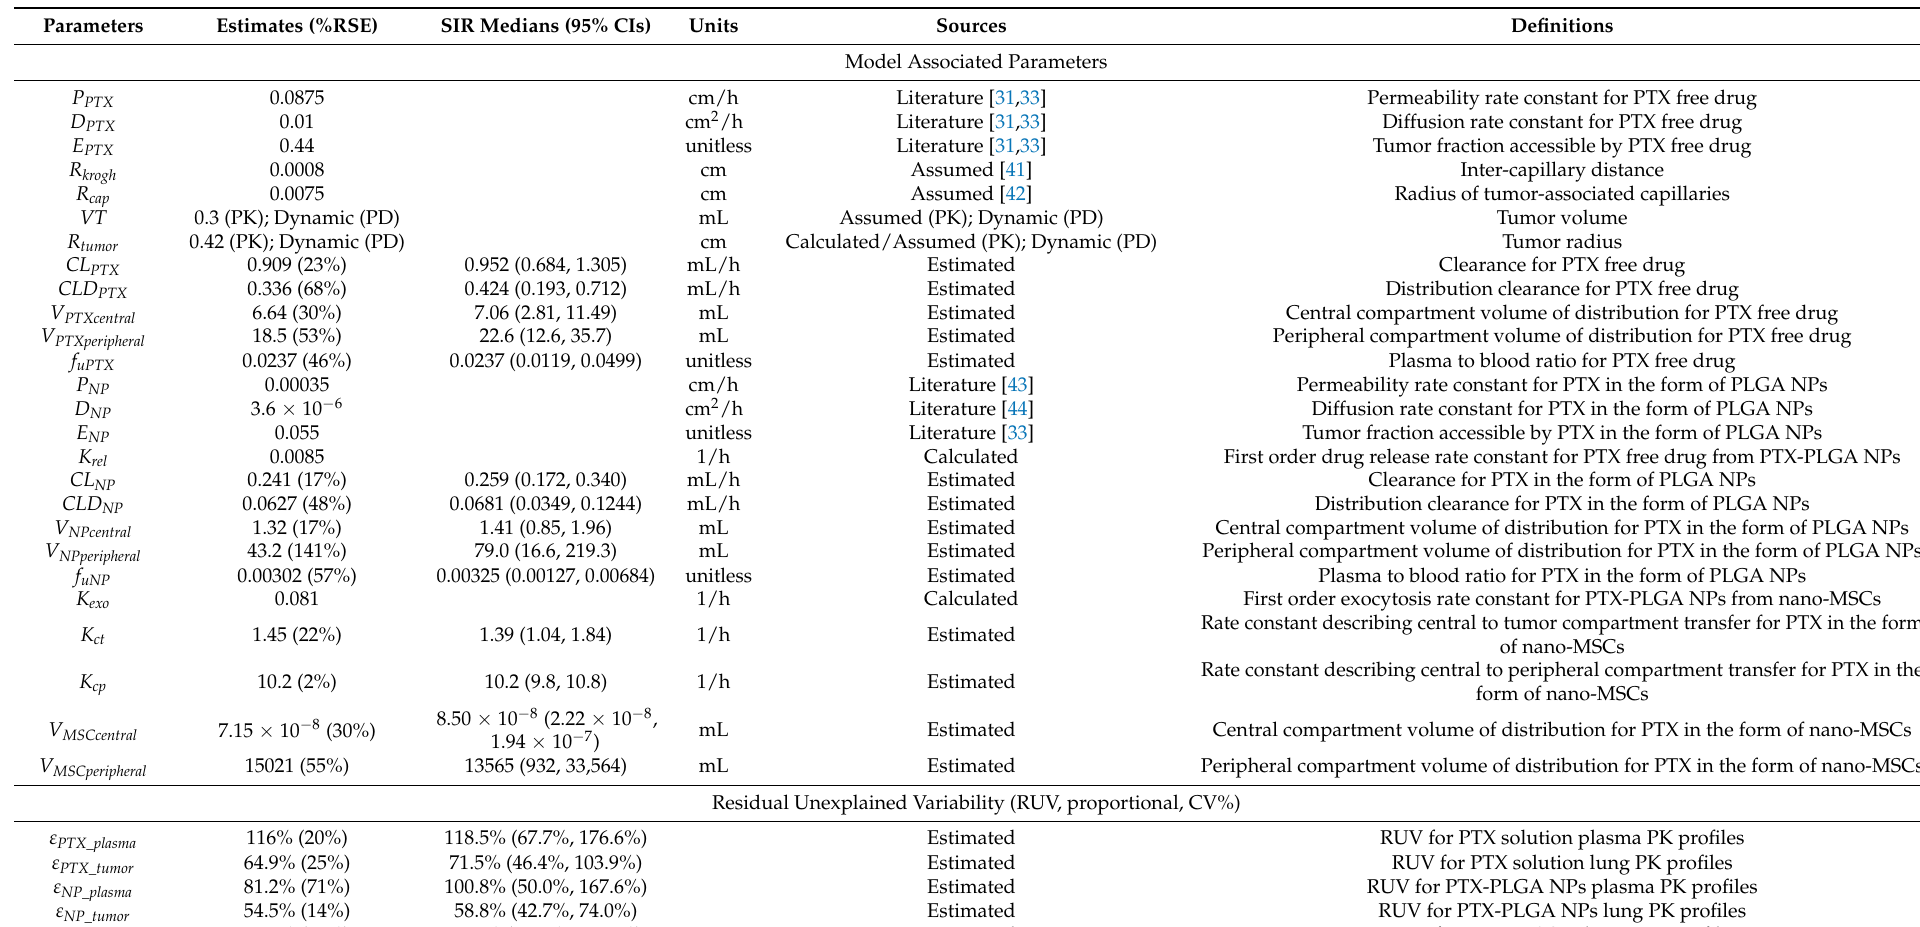
Table 1. Parameters for pharmacokinetic